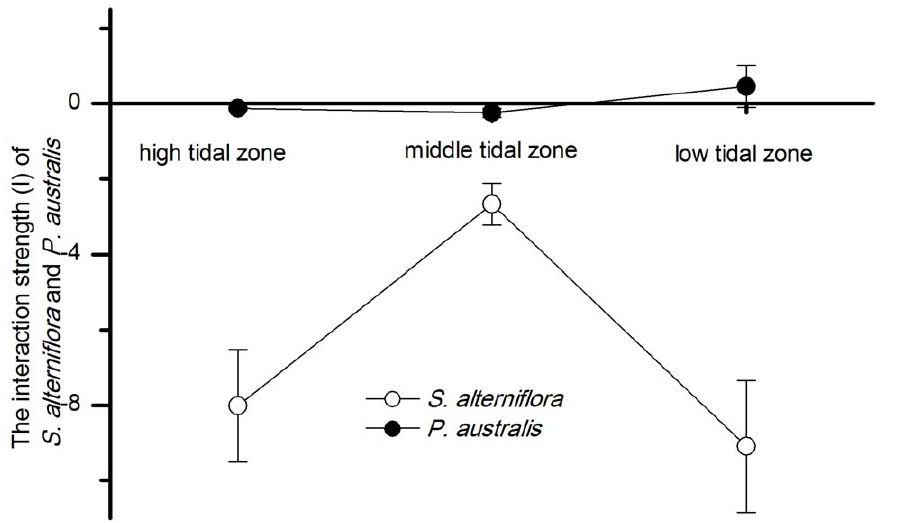
Figure 6. The interaction strength (I) of P.australis and S.alterniflora along the tidal gradient. The performance of targets was measured by the number of newly produced tillers per day